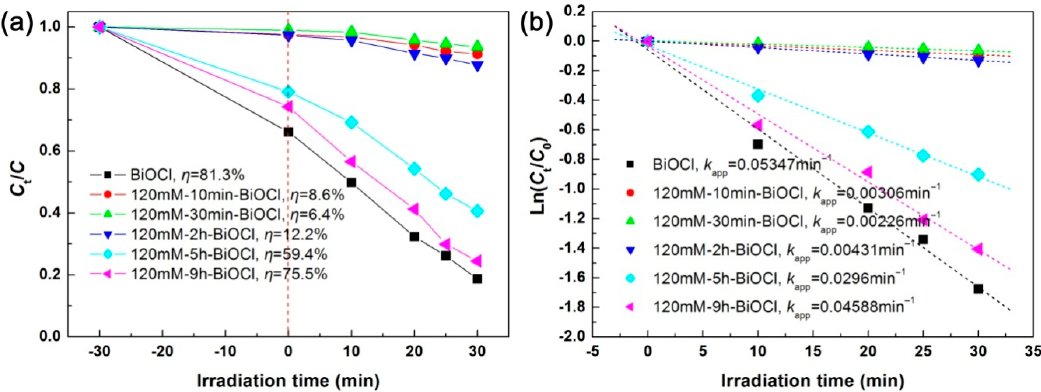
Figure 13. Time-dependent photodegradation of RhB ( a ) and kinetic plots of the dye degradation ( b ) over the 120 mM NaBH 4 -treated BiOCl samples with different treatment times.